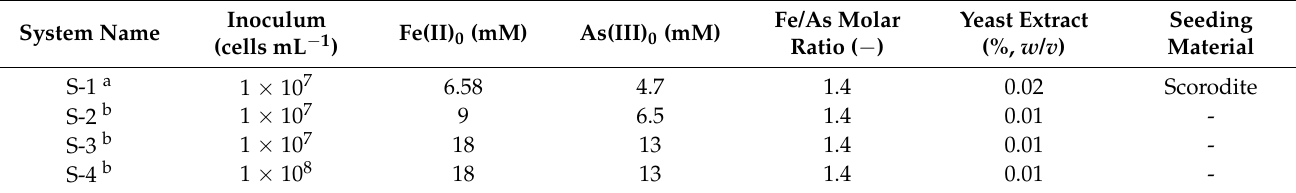
Table 2. Characteristics of the experiments employed for model